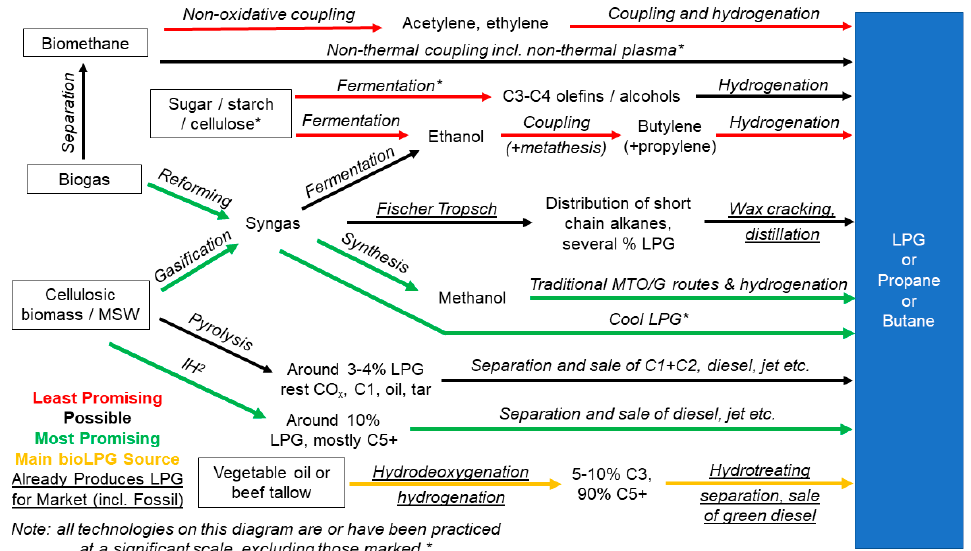
Figure 1. Main bioLPG production routes.